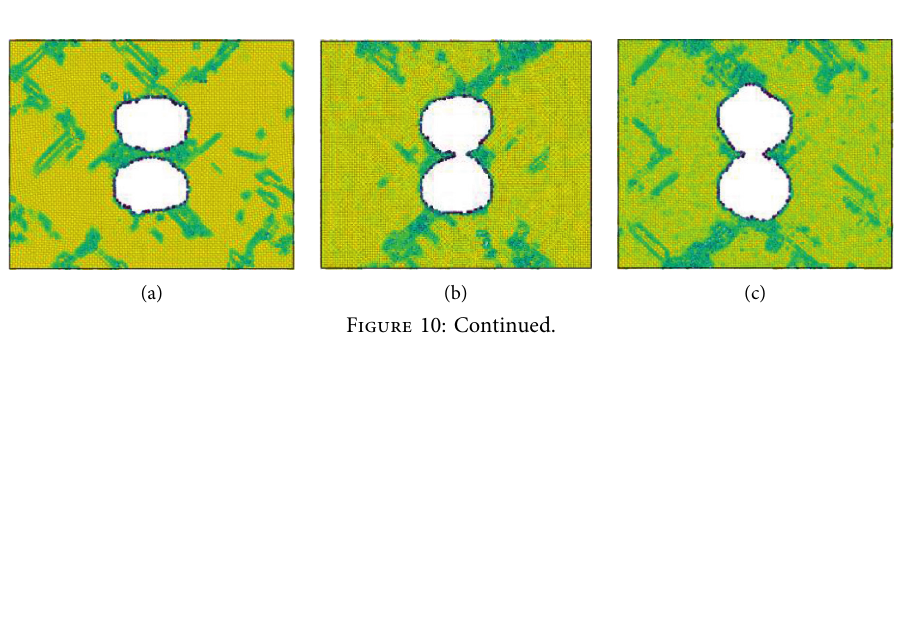
Figure 9: The curve of dislocation-stress-time with different compressive